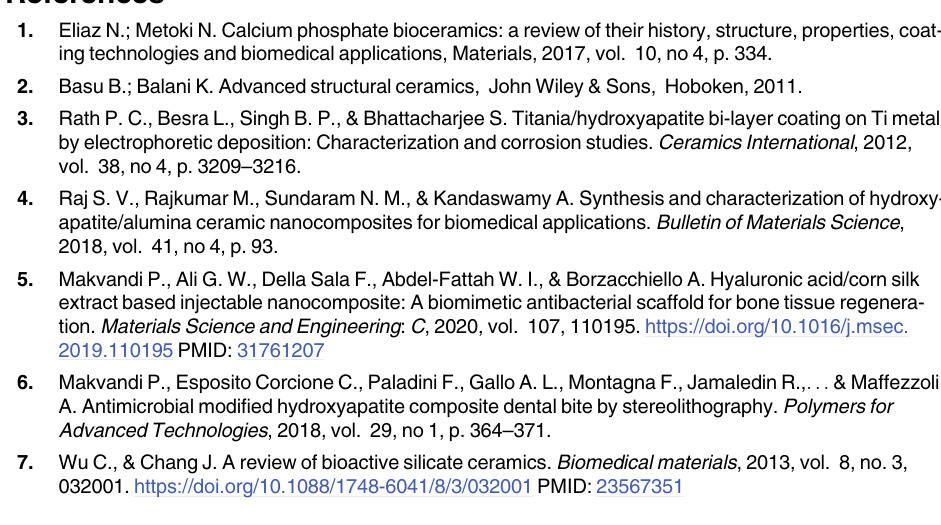
S1 Fig. Graphical abstract. S1 Data. Table 2 shows the calculated values of FWHM, area of the crystalline phase and the complementary parameter for the XRD peak